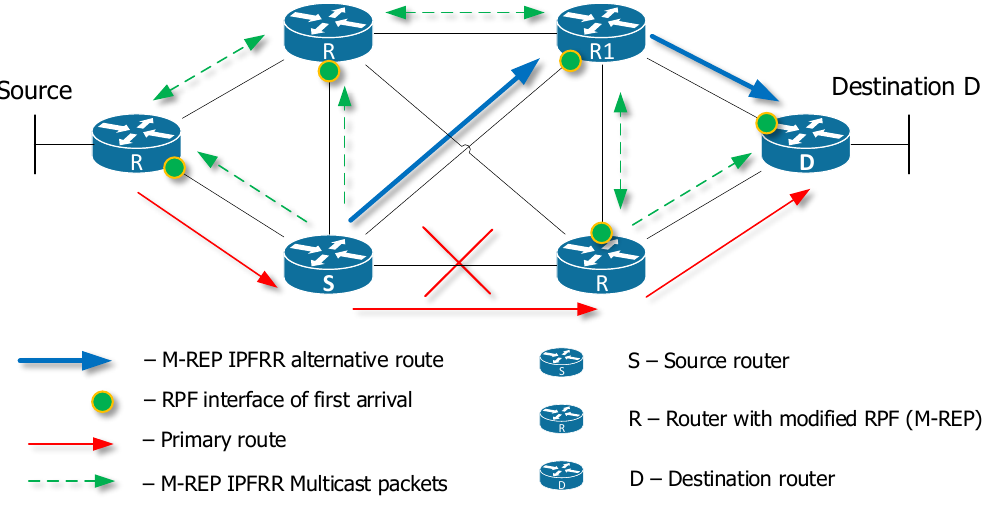
Figure 3. Multicast Repair (M-REP) IP FRR mechanism. RPF, Reverse Path Forwarding.